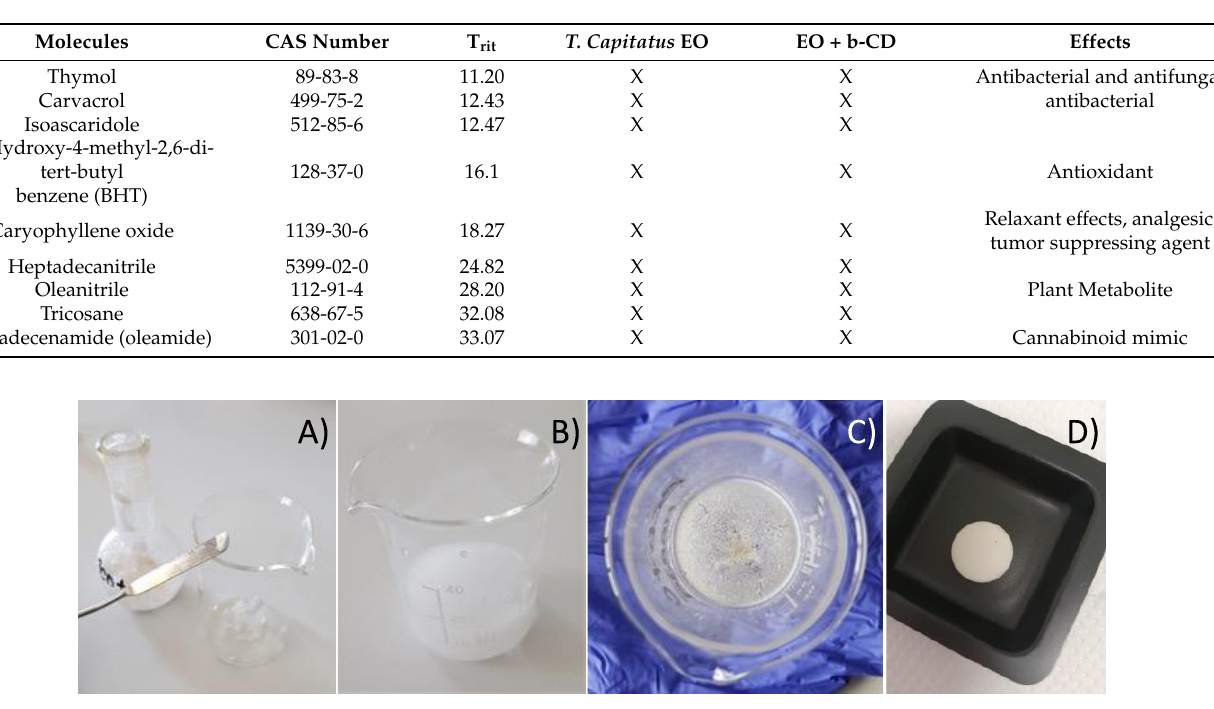
Table 2. Molecules found in both the T. capitatus EO and the relative tablet that show a biological function or are typical of this EO.